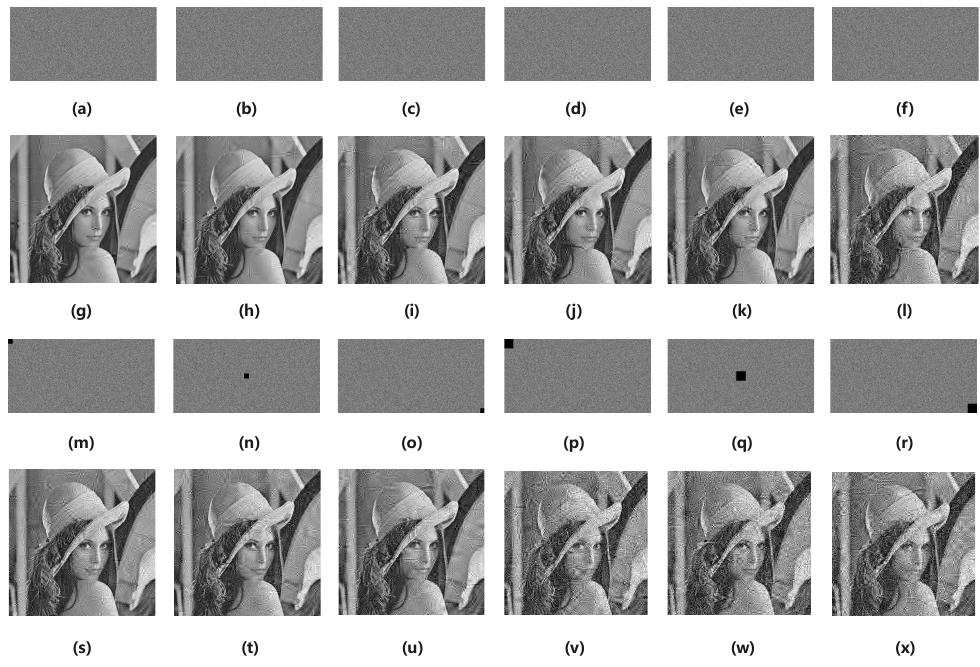
Figure 11. The robustness analysis result. ( a – f ) are cipher images with 1 × 10 − 4 , 2 × 10 − 4 , 3 × 10 − 4 , 4 × 10 − 4 , 5 × 10 − 4 , 1 × 10 − 3 salt & pepper noise, respectively. ( g – l ) are corresponding decrypted images. ( m – o ) are the cipher images with 16 × 16 data lost. ( s – u ) are corresponding decrypted images. ( p – r ) are the cipher images with 32 × 32 data lost. ( v – x ) are corresponding decrypted